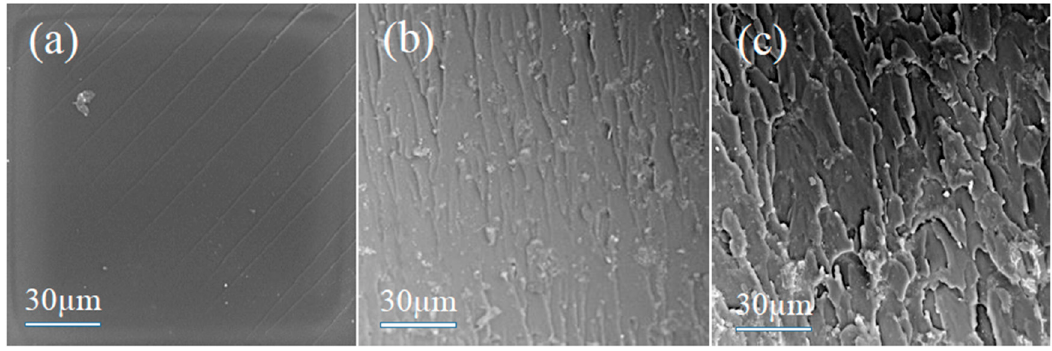
Figure 7. SEM images of ( a ) EP, ( b ) EP / NH 2 -MIL-101(Al), and ( c ) EP / IL@NH 2 -MIL-101(Al). Table 1. EDS analysis of EP, EP/NH 2 -MIL-101(Al), and EP/IL@NH 2 -MIL-101(Al).